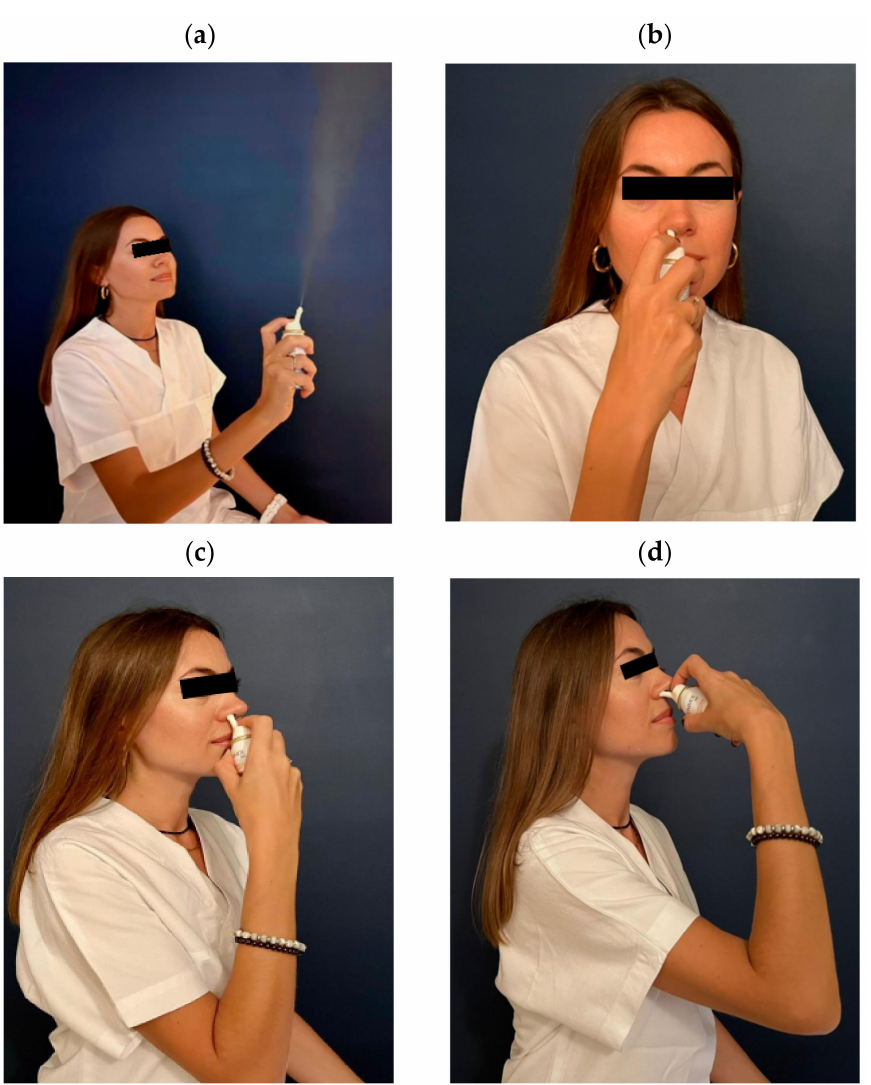
Figure 1. ( a – d ) Modality of spraying Tonimer Lab Panthexyl 800 inside the nasal cavity. The patient’s head must be kept in an upright position the intranasal nozzle device is first inserted vertically inside the nostril to penetrate 5 mm into the airspace and subsequently inclined upon the horizontal